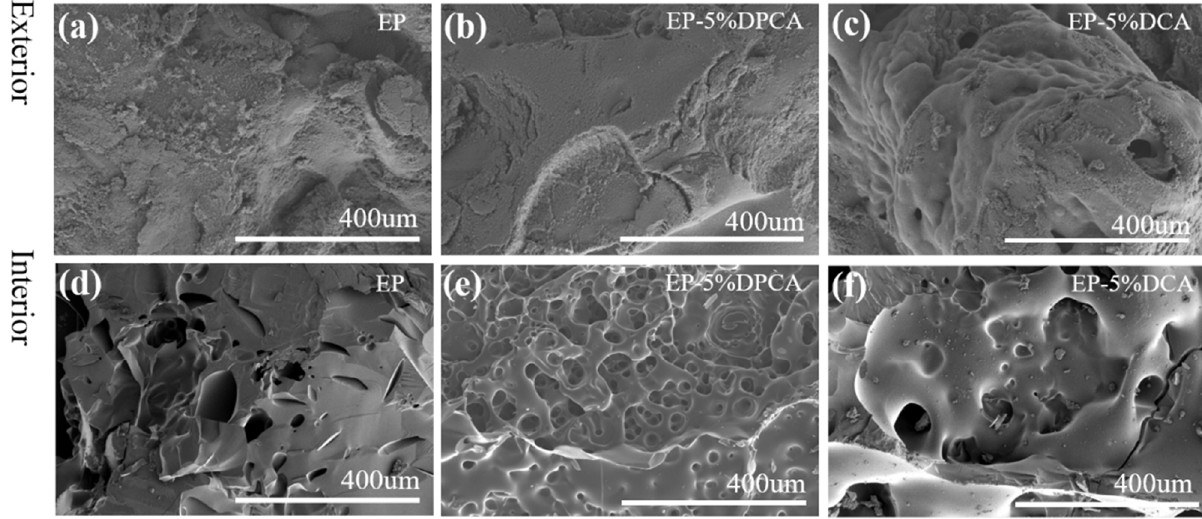
Figure 7: SEM images of char residues for ( a, d ) EP, ( b, e ) EP - 5 wt% DPCA, and ( c, f ) EP - 5 wt% DCA after UL - 94